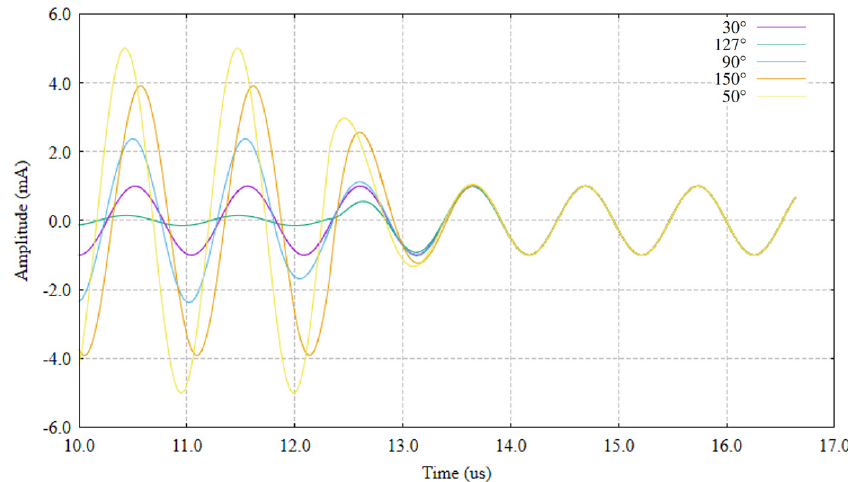
Figure 4. SPICE simulation of the oscillator (in ideal case) gm 1 = gm 2 = gm 3 = 1/ R 3 = 1 mA/V, C 1 = C 2 = 10 nF, R 1 = 1/ ( 2 π ) 2 k Ω . F sync is a sinusoidal voltage signal, with 1 MHz and 1 V pp .